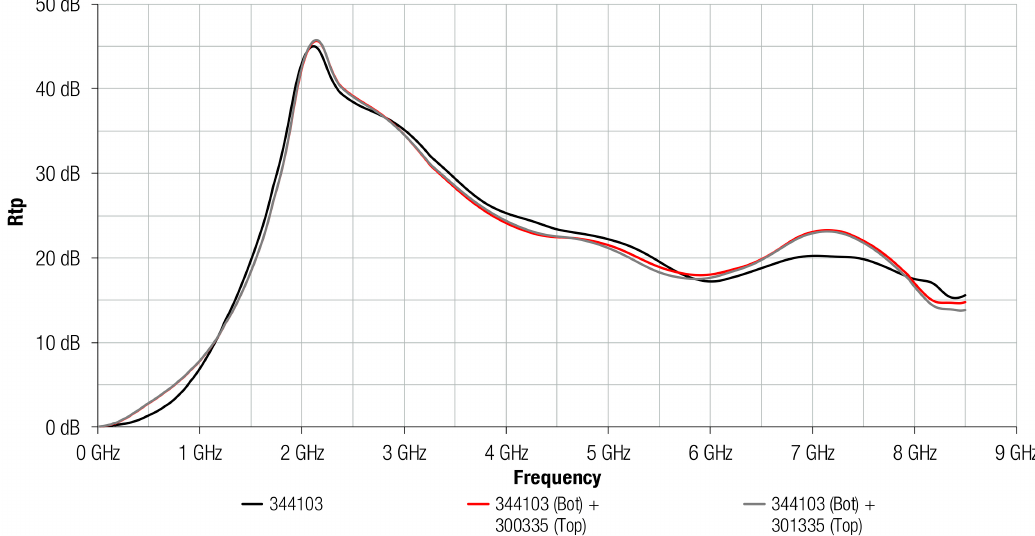
Figure 6. R tp of 344103 absorber sheet without any metal layer (black), 344103 absorber sheet with a Cu layer attached (red,) and 344103 absorber sheet with a Al layer attached (grey).